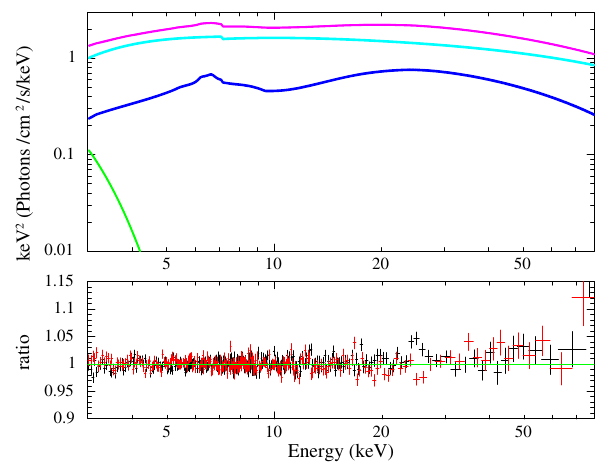
Fig. 4 The upper quadrant shows the total best-fit model in magenta with the individual components: the thermal spectrum ( diskbb ) is in green, the relativistic reflection spectrum ( relxillion_nk ) is in blue,andtheComptonizedspectrumfromthecorona( cutoffpl )isin cyan. The lower quadrant shows the data-to-best-fit model ratio, where the red and black colors represent the data from the FPMA and FPMB sensors, respectively